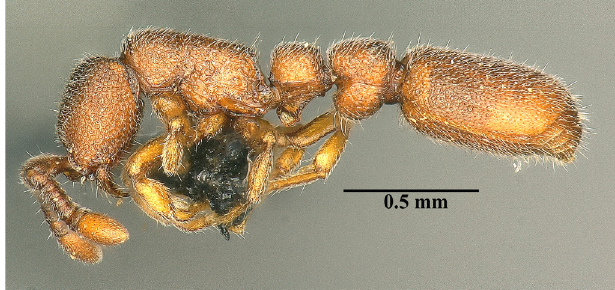
Fig 3 . Ooceraea octoantenna Zhou & Chen sp. nov.,worker holotype, body in profile view.